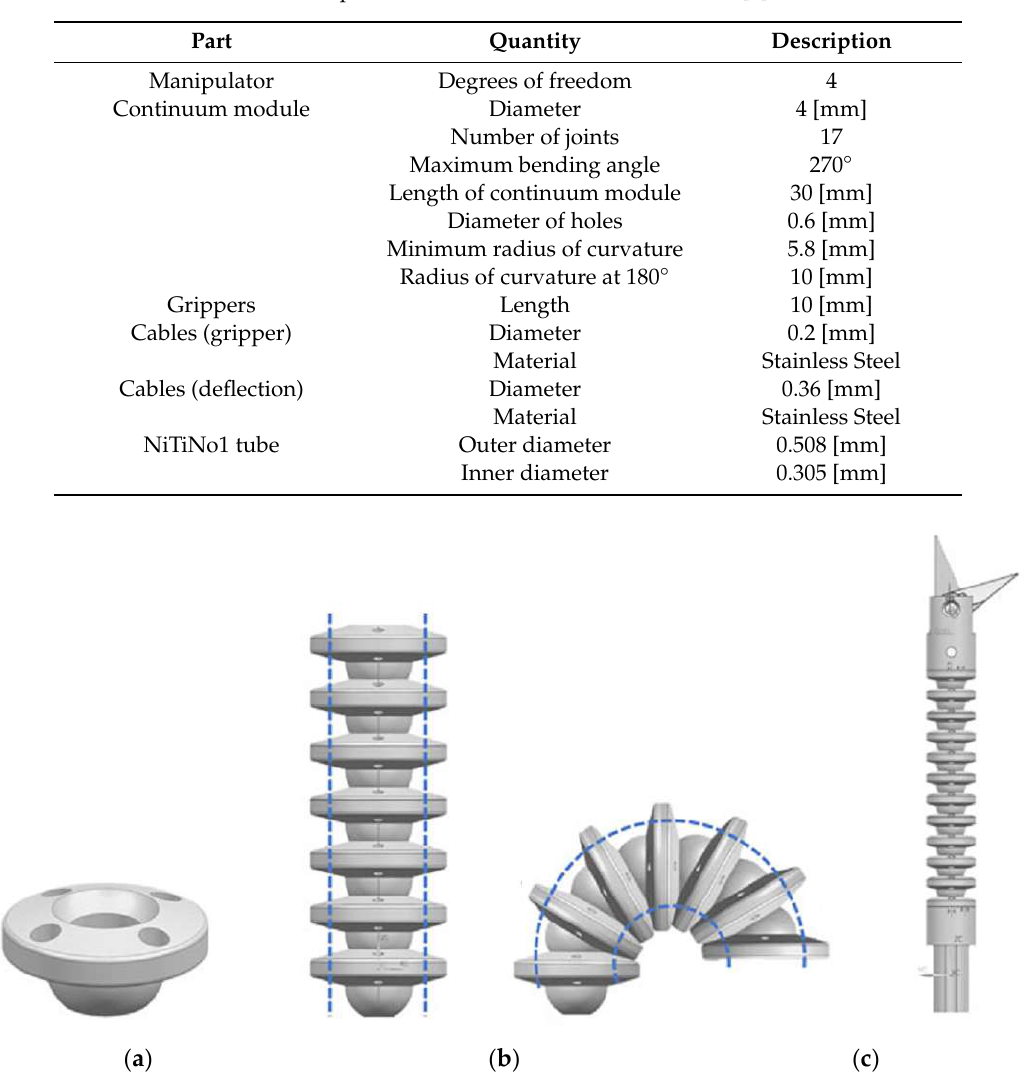
Table 1. Specifications of a continuum sinus robot [3].